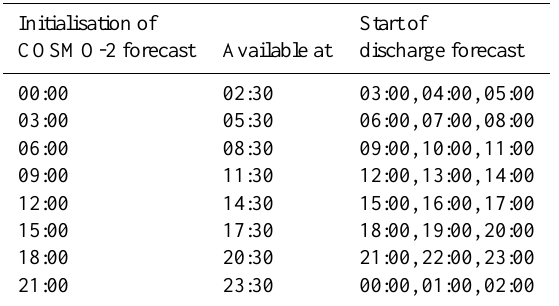
Table 1. COSMO-2 forecasts connected to discharge nowcasts forced by REAL, deterministic radar QPE (RAD) and interpolated rain-gauge data (PLU). Times are in hours